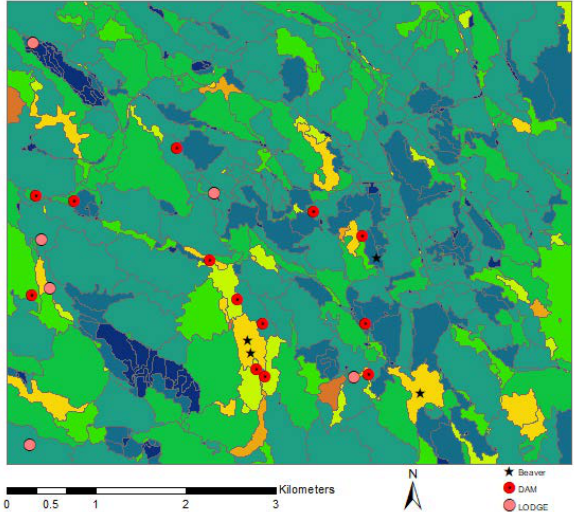
Figure 2. Open water extent map.